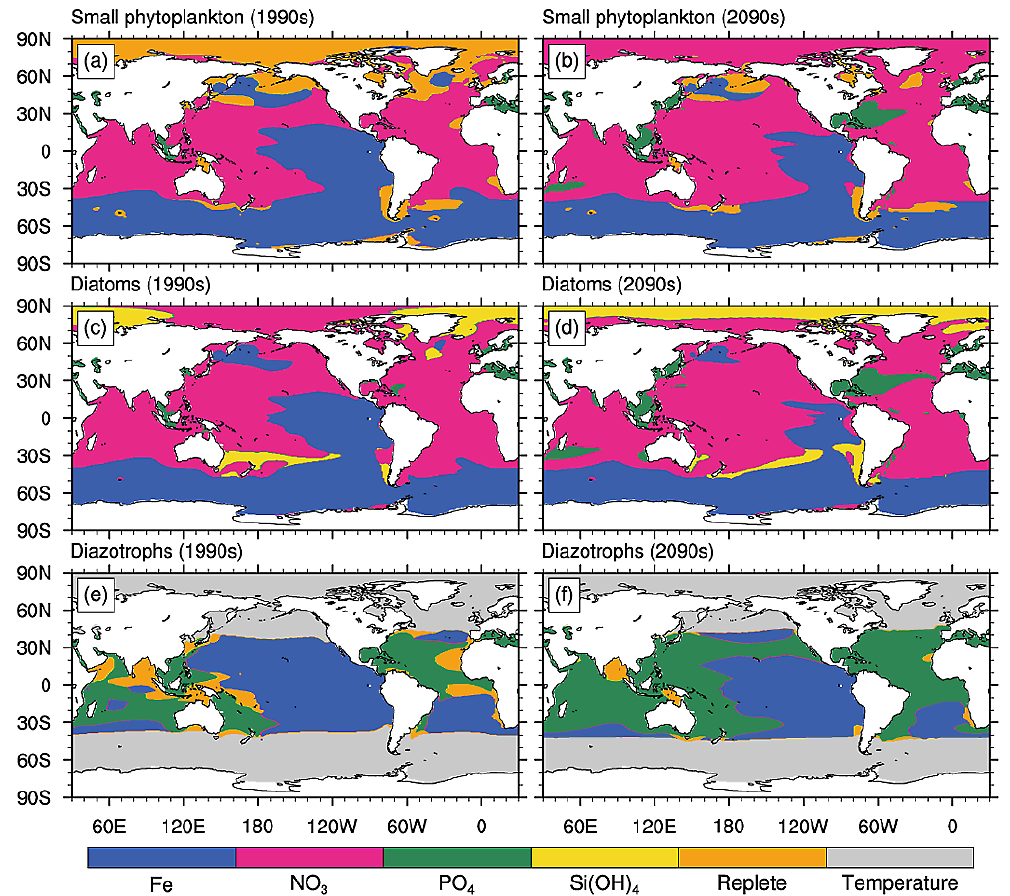
Fig. 5. Spatial distributions of the simulated most-limiting factor for phytoplankton growth at an annual timescale during the 1990s ( a , c , and e ) and the 2090s ( b , d , and f ) for small phytoplankton ( a and b ), diatoms ( c and d ), and diazotrophs ( e and f ). The relative availability of each nutrient was determined from the uptake half-saturation constant for each phytoplankton group; the nutrients with minimum availability are